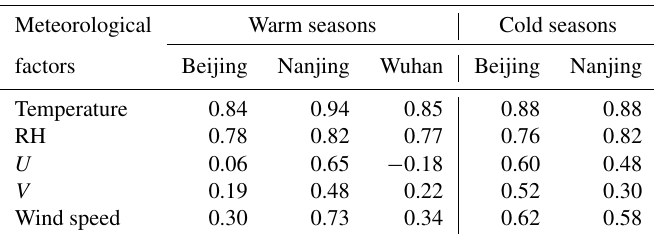
Table 3. Summary of correlation coefficients for hourly meteorological factors in different cities. RH, U and V represent relative humidity, U wind and V wind,